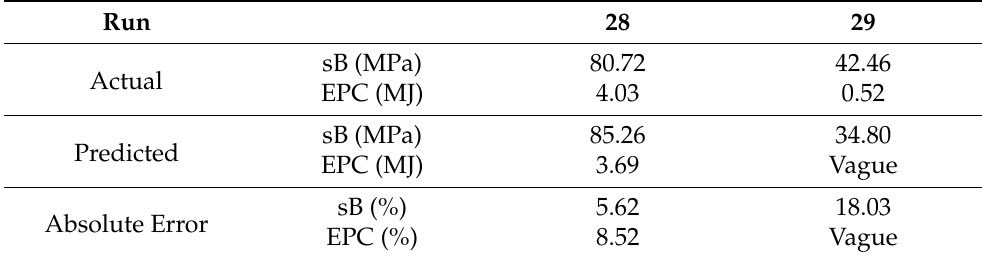
Table 8. Validation